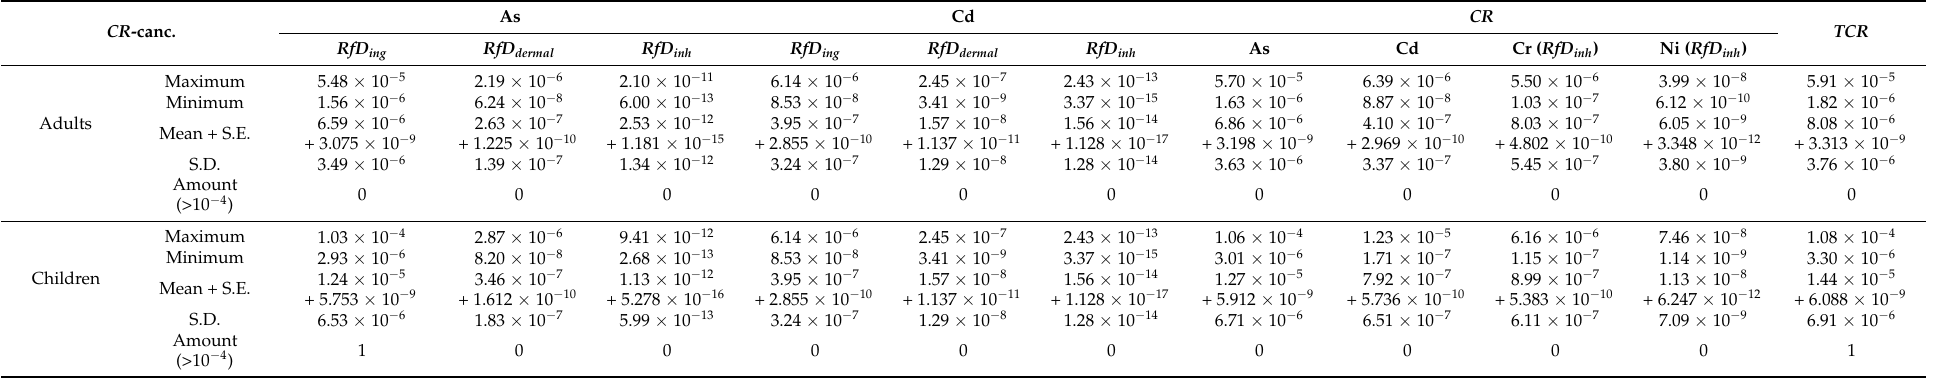
Table 7. The carcinogenic health risk index ( CR ) of ingestion, dermal contact, and inhalation of soils for adults and children in the study area. CR